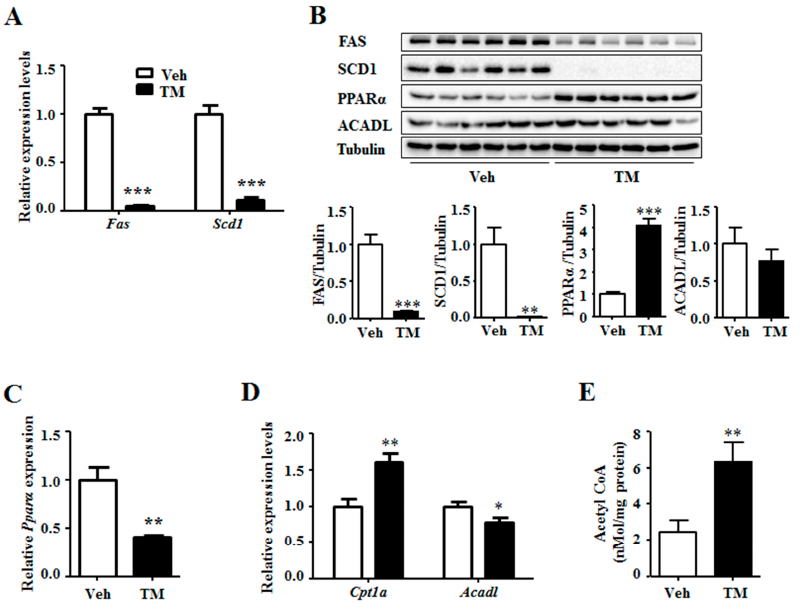
Figure 4. Tunicamycin inhibited the expression of liver lipogenic genes and increased the protein level of PPAR α . ( A ) Expression of lipogenic genes; ( B ) Protein levels of lipogenic and fatty acid oxidation related genes; ( C ) Expression of fatty acid oxidation stimulator gene Ppar α . ( D ) Expression of fatty acid oxidation related genes; ( E ) The acetyl CoA content in the liver. N = 6 per group. Veh, vehcle; TM, tunicamycin. * p < 0.05, ** p < 0.01, *** p < 0.001 TM vs. Veh.